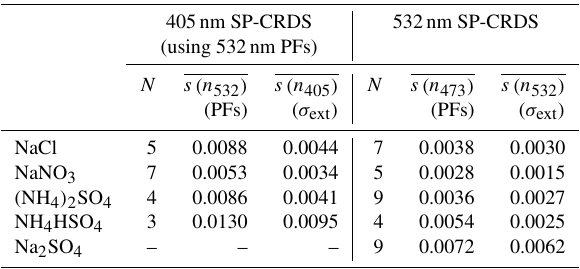
Table 1. Information relating to the precision of n λ measured from SP-CRDS for aqueous NaCl, NaNO 3 , (NH 4 ) 2 SO 4 , NH 4 HSO 4 and Na 2 SO 4 droplets. N is the number of data sets available for phase function and extinction cross section ( σ ext ) analysis from either 405nm or 532nm SP-CRDS. The mean standard deviation in the retrieved n λ , s (n λ ) is reported for both extinction cross section and phase function (PF)